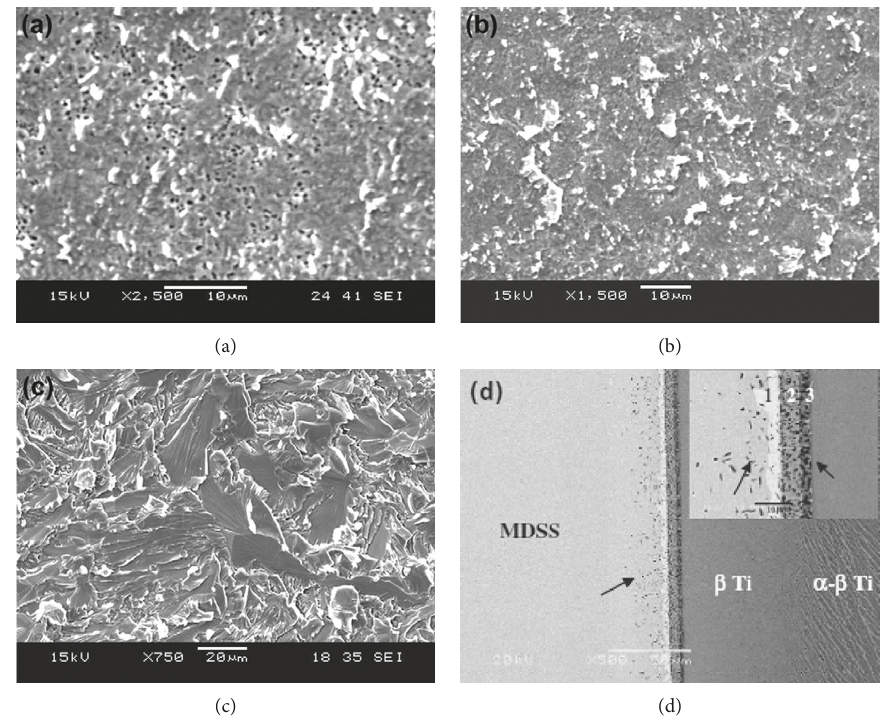
Figure 3: Fracture morphology of the bonded joints at (a) 850 ° C; (b) 900 ° C; (c) 950 ° C for 45 min at stainless steel side; (d) BSE micrographs of the diffusion-bonded sample at 1000 ° C for 45min and enlarge view at inset: (1) σ ; (2) λ +FeTi; and (3) λ +FeTi+ β -Ti (the arrows show the microvoids) (reproduced from [64] with Table 1: Growth kinetics of the reaction layers. Interface layers